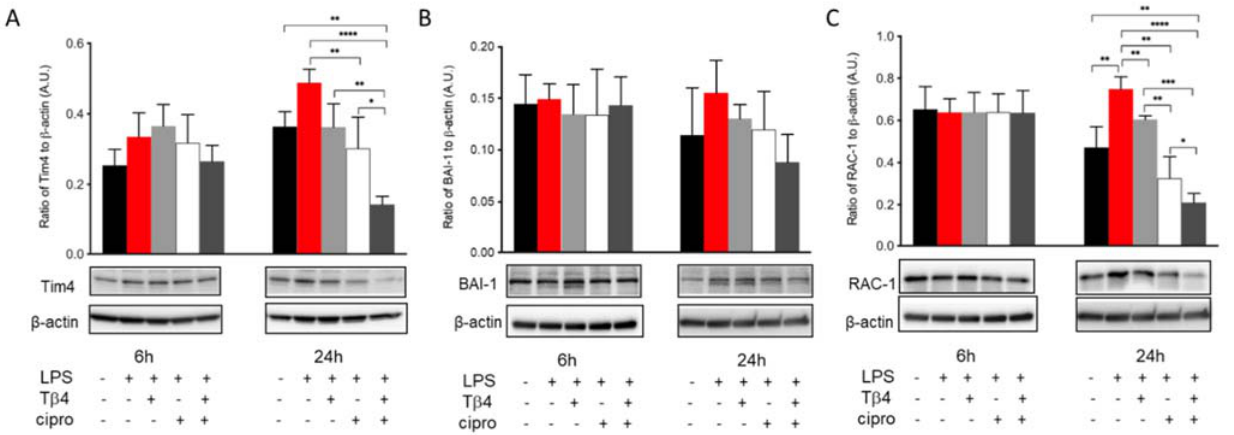
Figure 7. In vitro assessment of efferocytosis activity following LPS-induced stimulation of M Φ . Efferocytosis activity was measured from RAW 264.7 cells by Western blot at 6 and 24 h after LPS stimulation. Tim4 ( A ), BAI-1 ( B ), and Rac-1 ( C ) levels are presented as a ratio to β‐ actin ± SD. n (cid:3410) 3 corneas/group; * p < 0.05, ** p < 0.01, *** p < 0.001, **** p < 0.0001.